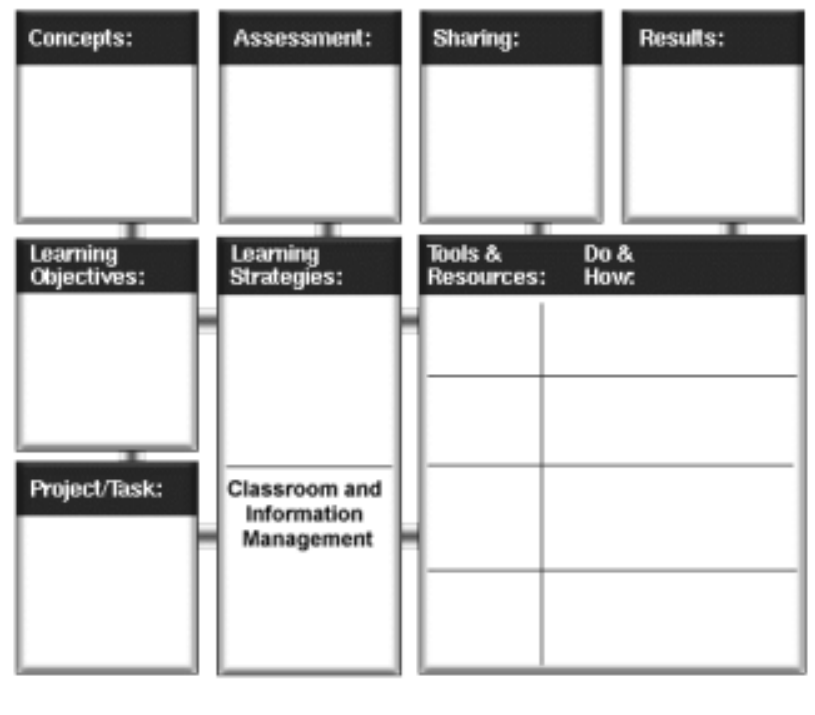
Figure 4: Lesson Planning Template (from Ohio Schoolnet)